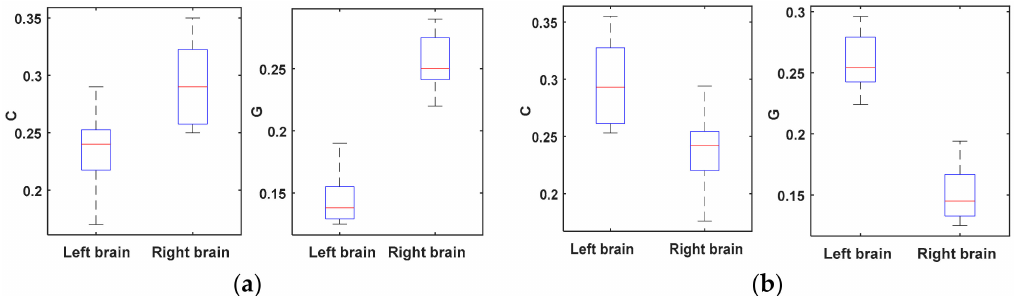
Figure 9. The difference of brain network parameters when a subject turns right or left. ( a ) Move to the left; ( b ) move to the